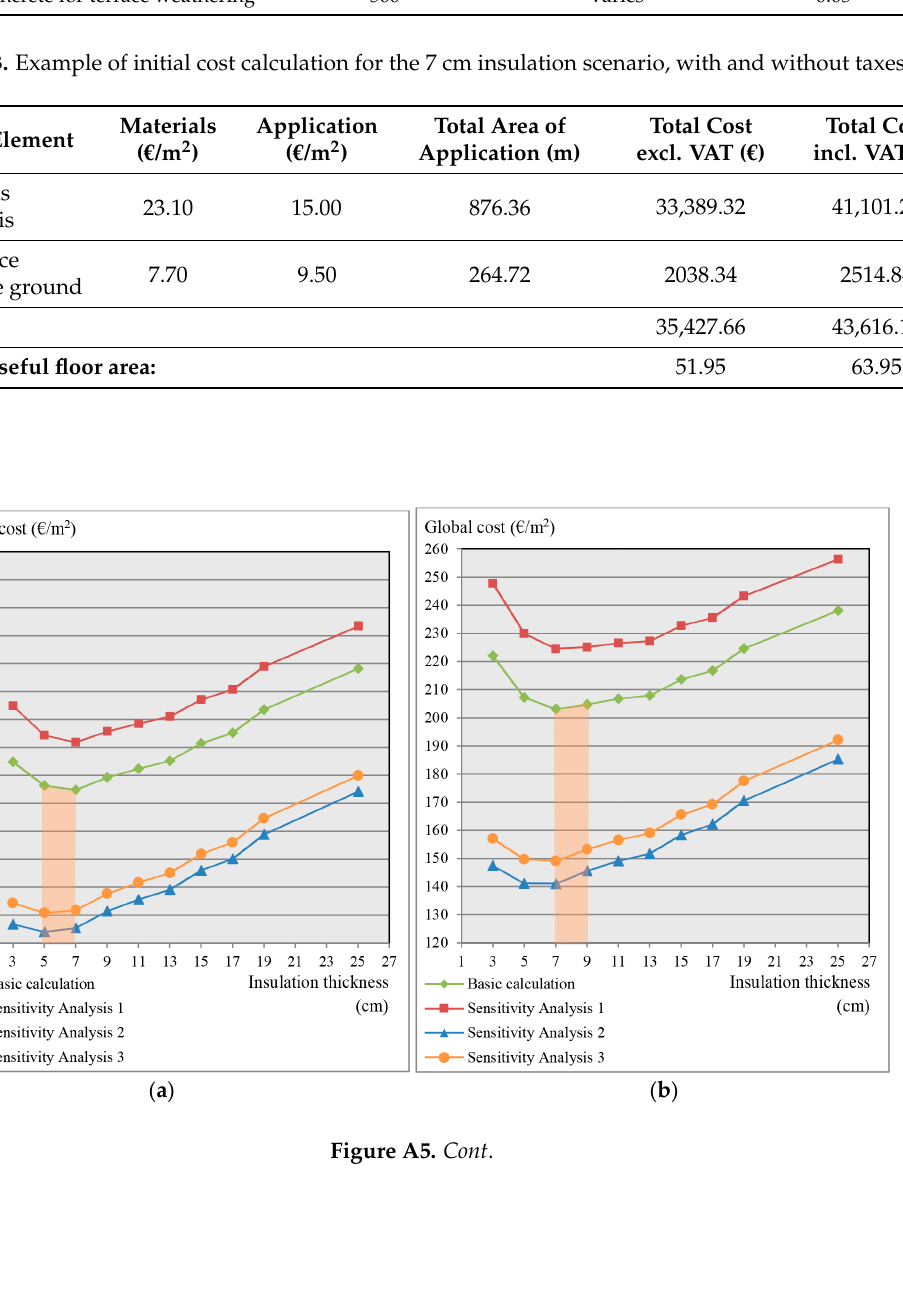
Table A2. Thermal/physical characteristics of building materials used on the reference building [14].